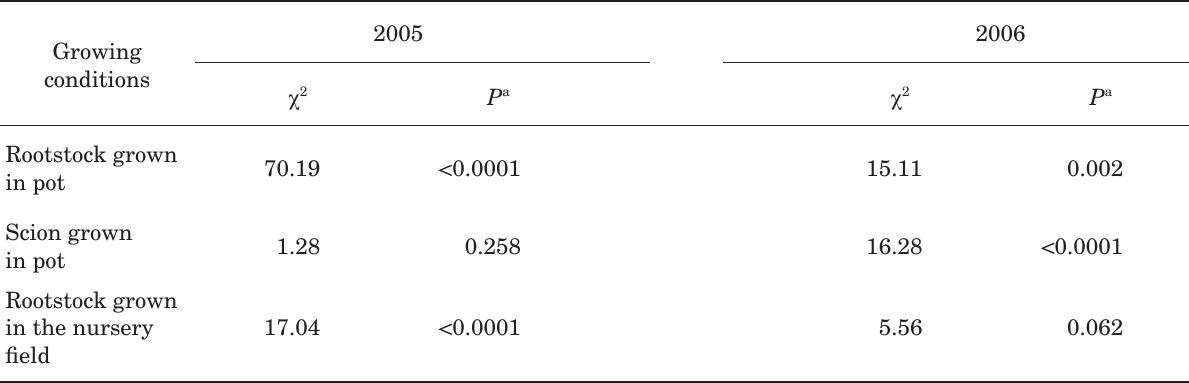
Table 2. χ 2 test of independent groups for strike rates of treated or untreated rootstock and scion cuttings grown in different conditions in 2005 and